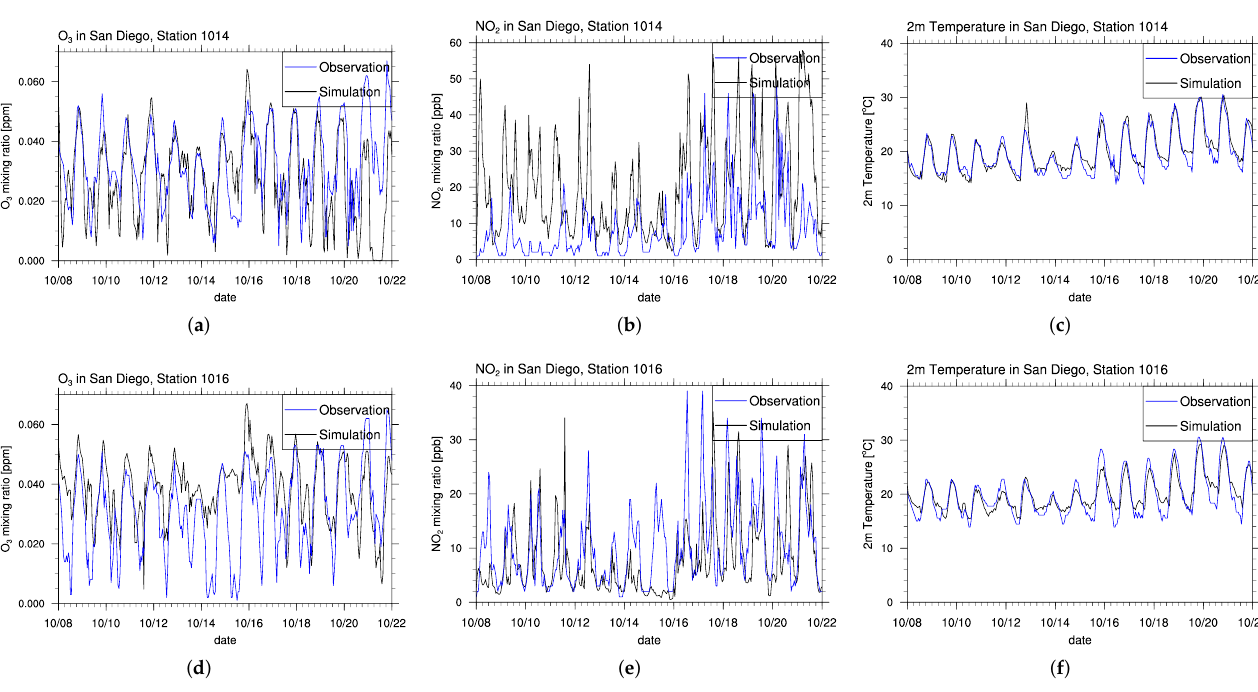
Figure 12. Comparison of in situ measurements with modeled ozone and NO 2 as well as 2 m temper- ature at the ground at San Diego, i.e., Donovan ( a – c ) and Kearny Villa Road ( d – f ) in October